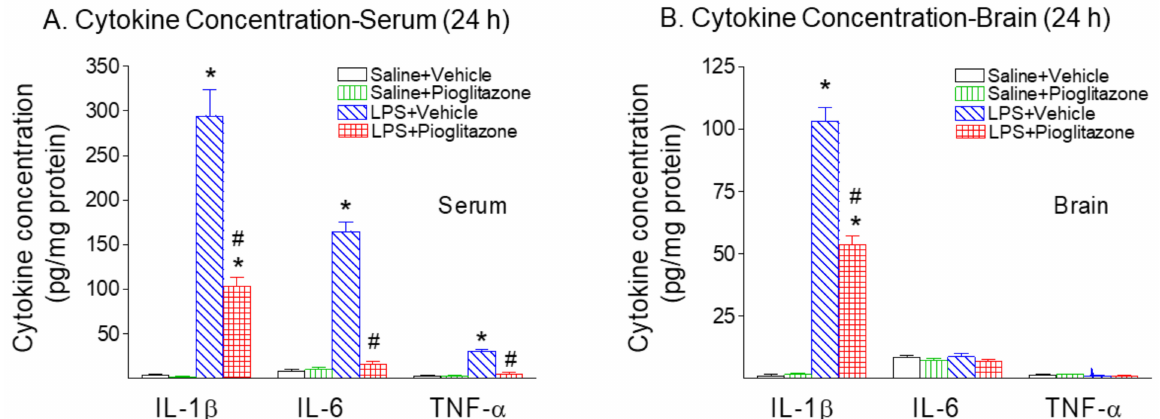
Figure 9. Pioglitazone attenuated neonatal LPS-stimulated increases in inflammatory cytokines (IL-1 β , IL-6 and TNF- α ) in the rat serum ( A ) and brain ( B ) 24 h after LPS injection. IL-1 β , IL-6 and TNF- α concentrations were determined by ELISA and presented as units of pg/mg protein, as described in the Methods section. Twenty-four hours following LPS injection, serum levels of IL-1 β , IL-6 and TNF- α ( A ), and brain levels of IL-1 β were elevated as compared with the Saline+Vehicle group. Treatment with Pioglitazone attenuated LPS-induced contents of IL-1 β , IL-6 and TNF- α . The results are expressed as the mean ± SEM of eight animals in each group, and analyzed by two-way ANOVA, followed by the Student–Newman–Keuls test. * p < 0.05 represents a significant difference for the LPS + Vehicle group or LPS + Pioglitazone group as compared with the Saline + Vehicle group. # p < 0.05 represents a significant difference for the LPS + Pioglitazone group as compared with the LPS + Vehicle